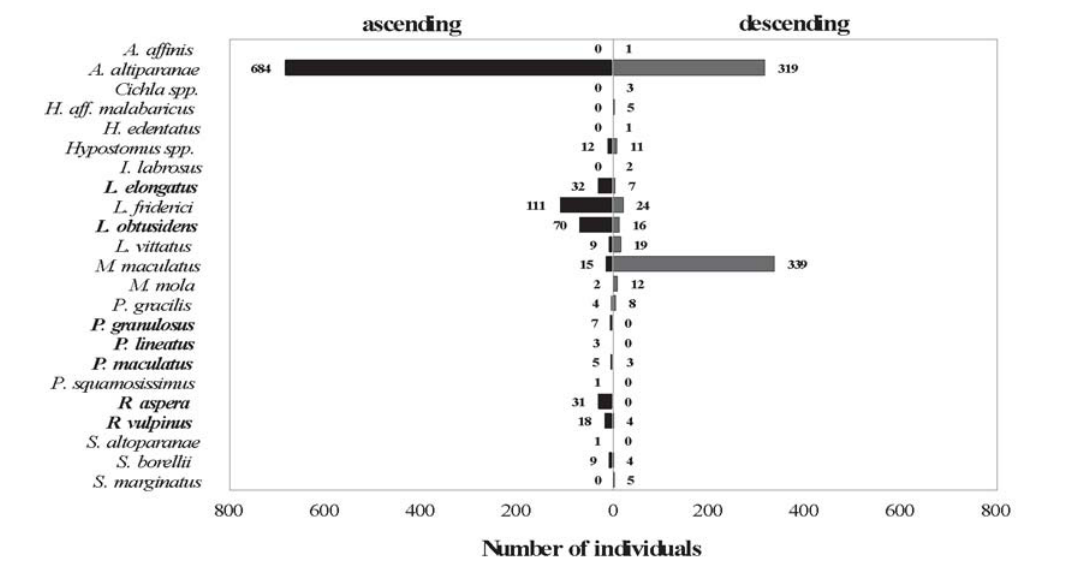
Fig. 6. Number of individuals for species captured in Protocol II (assessment of ascending and descending movements). Migratory species are in